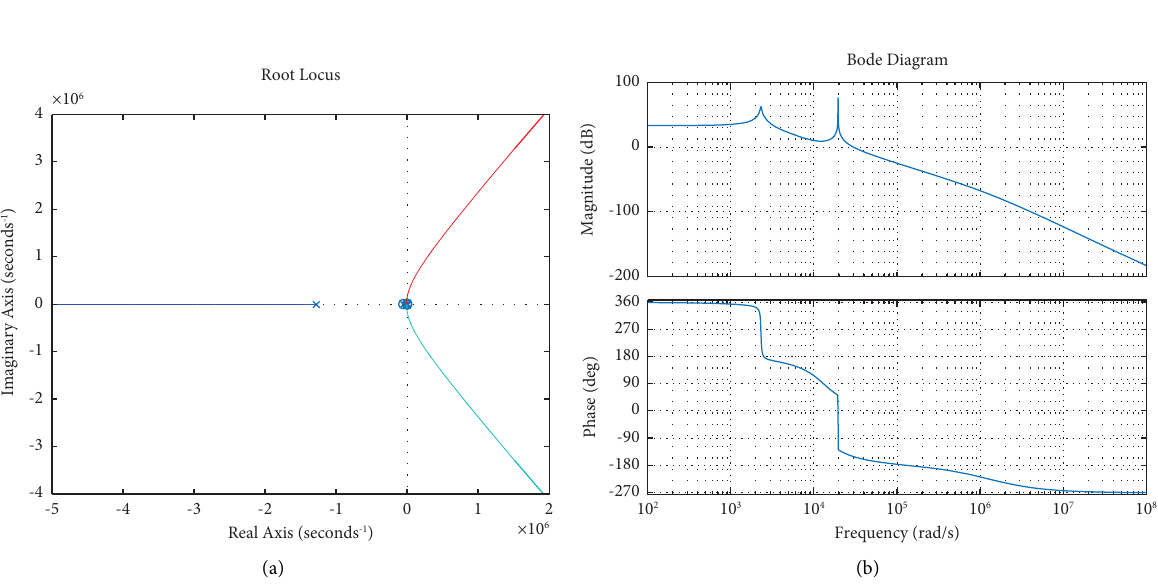
Figure 20: Cuk converter with LCL flter: (a) root locus; (b)